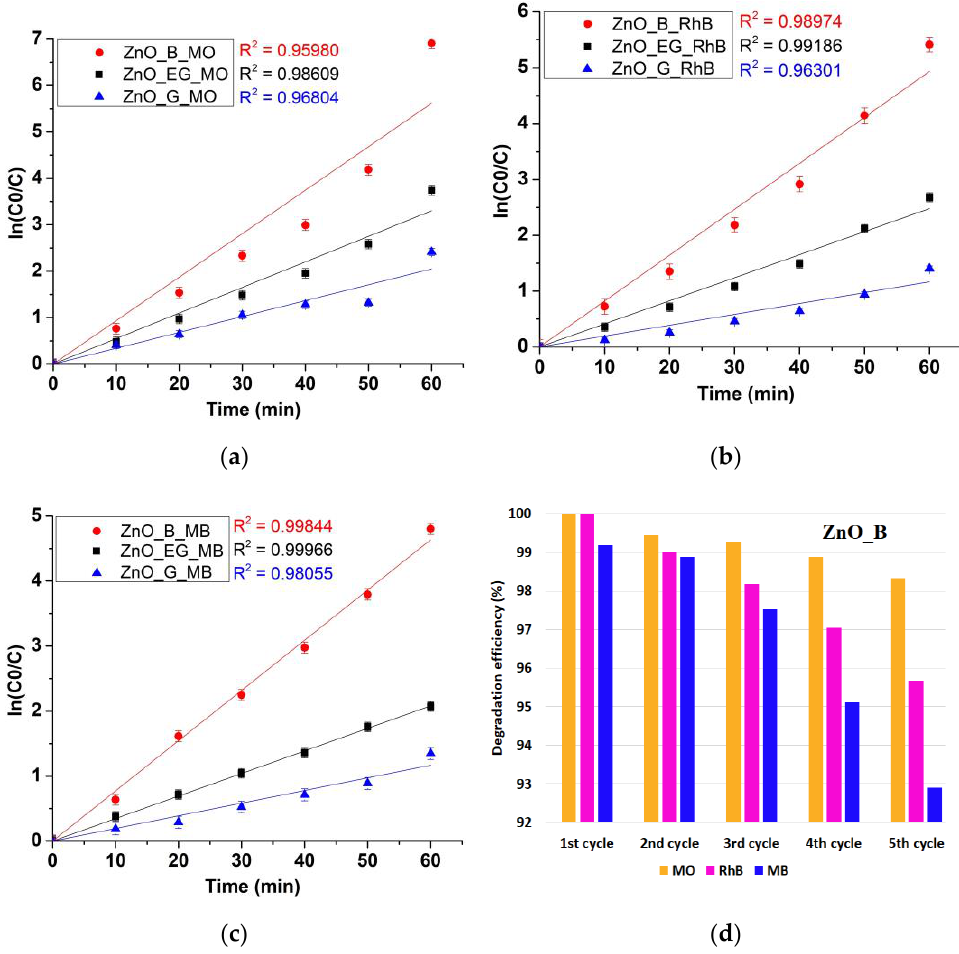
Figure 10. Determination of k app by plotting ln(C 0 /C) vs time for each dye from the MO + RhB + MB mixture: MO ( a ); RhB ( b ); MB ( c ); degradation efficiency for ZnO_B sample over five photocatalytic cycles against MO + RhB + MB mixture ( d ).